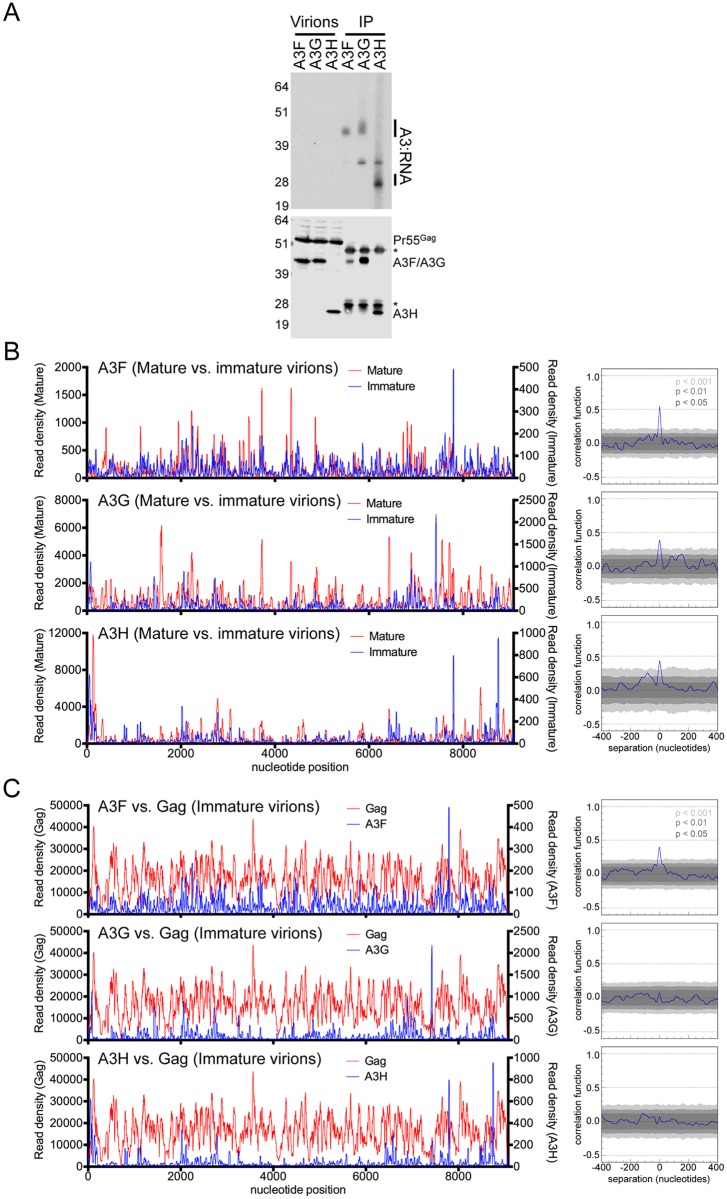
Interplay between A3 and Gag RNA binding to HIV-1 RNA in immature virions.(A) A3-RNA cross-linked complexes were immunoprecipitated from purified immature (PR defective) HIV-1NL4-3 ΔVif virions derived from proviral plasmid-transfected HEK 293T cells stably expressing 3×HA-tagged A3F, A3G or A3H proteins. Complexes were visualized by autoradiography (top) and simultaneous Western blot analyses using anti-HA and anti-Gag antibodies (bottom). Asterisks indicate the presence of IgG heavy and light bands in the immunopreciptated fractions. (B) Comparisons of read density frequency distributions on the HIV-1NL4-3 genome for CLIP experiments in which A3 was immunoprecipitated from purified mature or immature virions (left). Correlation analyses of A3 binding frequencies across the viral RNA genome in mature and immature virions (right). (C) Comparisons of read density frequency distributions on the HIV-1NL4-3 genome for CLIP experiments in which A3 or Gag was immunoprecipitated from immature virions (left). Correlation analyses of A3 and Gag binding frequencies across the viral RNA genome in immature virions (right).